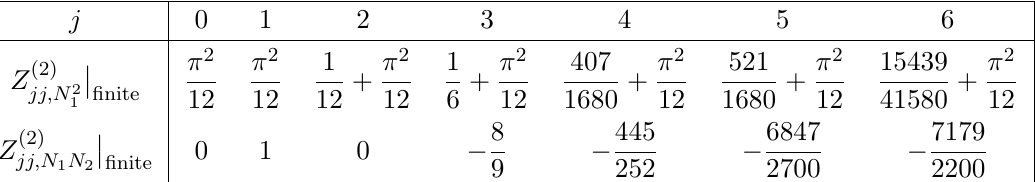
Table 1. Finite diagonal part of the two-loop renormalization matrix up to spin 6. This will be used to normalize the structure constants. The color notation is the same as in (5.8). Next, in table 1 I spell out the (cid:12)nite diagonal part of the renormalization matrix Z for the two-point functions of the operators (5.1), which I have computed up to spin